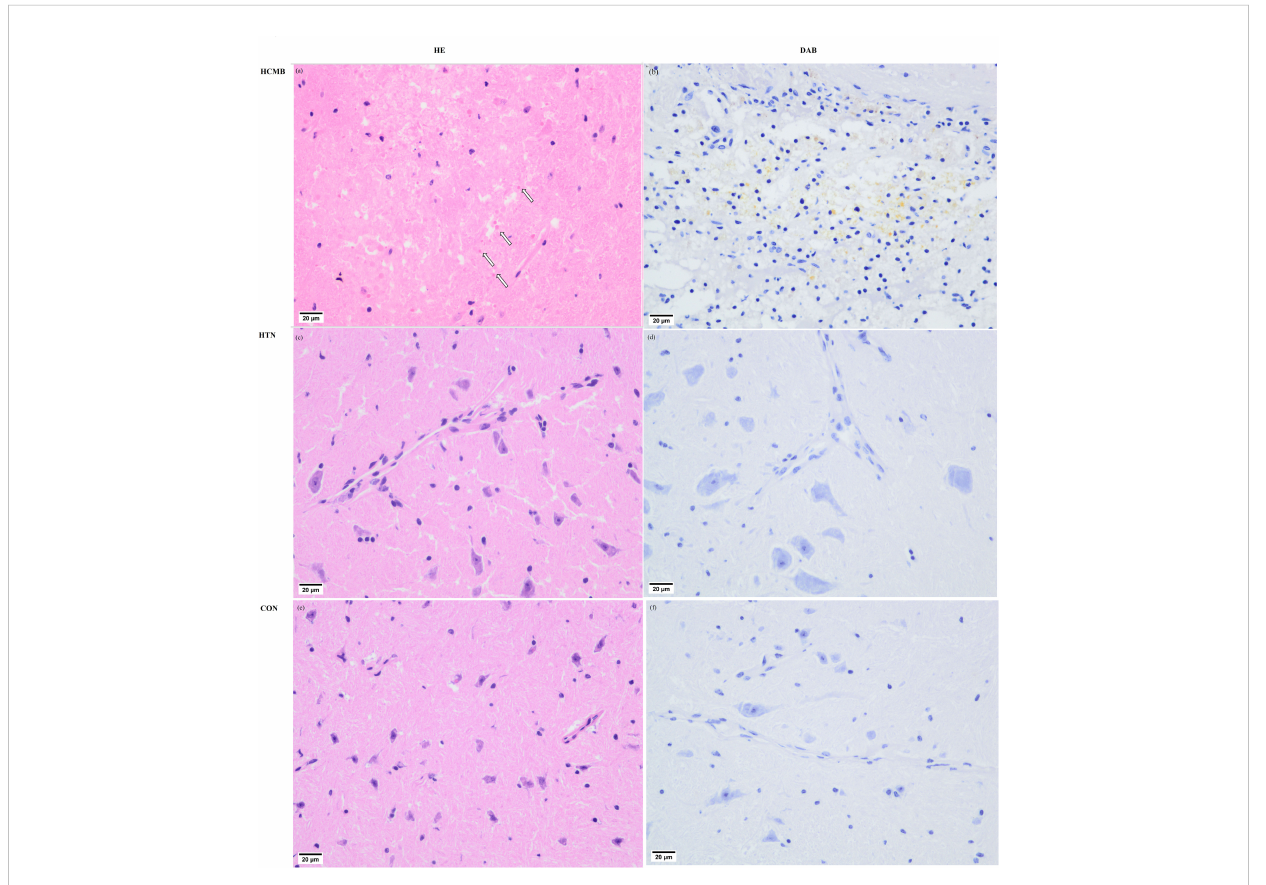
FIGURE 4 Pathological images of cerebral microbleeds. (A) Hematocrit enrichment map of hypertensive cerebral microbleeds tissue. In the ICH, blood cells are evident where the HE-stained arrows point in the diagram, and (B) DAB-stained blood cells (pale yellow) are visible in the diagram. diaminobenzidine staining images of hypertensive cerebral microbleeds. (C) HE stained picture of brain tissue in the hypertensive group. (D) DAB staining of brain tissue in the hypertensive group. (E) HE staining map of brain tissue in the control group. (F) DAB staining map of brain tissue in the control